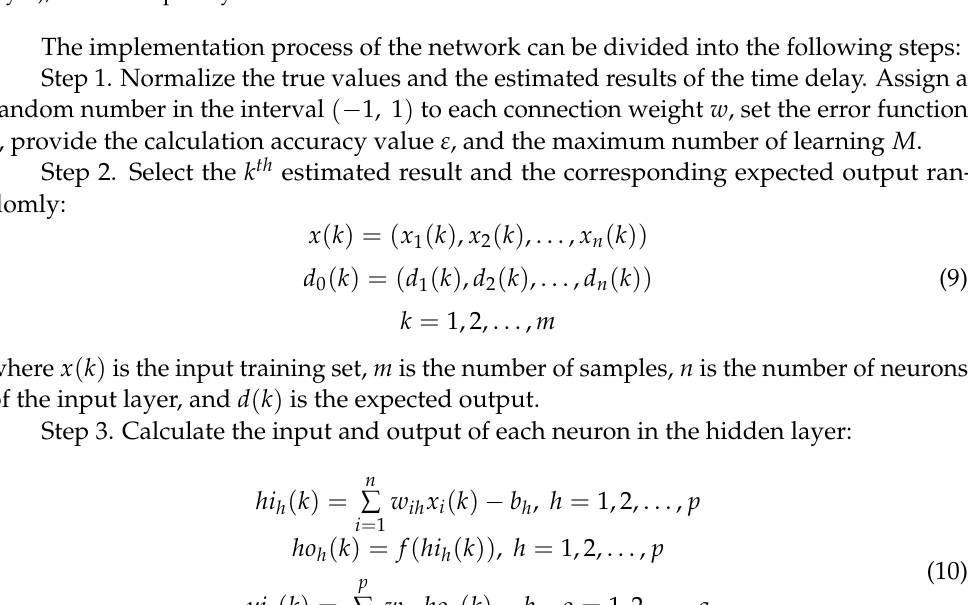
Figure 2. A typical BP neural network structure includes an input layer, a middle layer (hidden layer), and an output